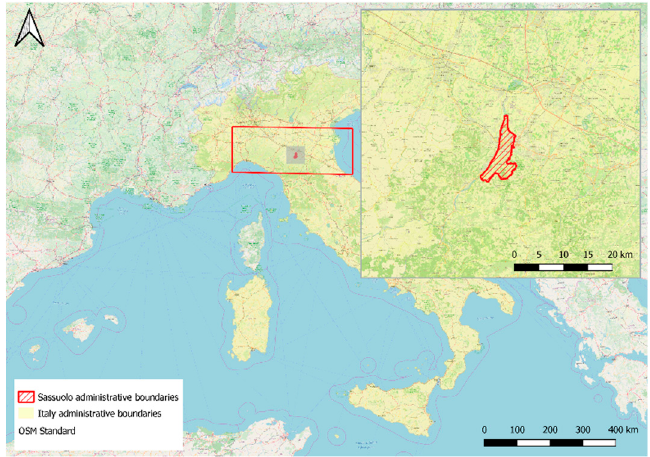
Figure 1. The location of the study area in Sassuolo, Italy.